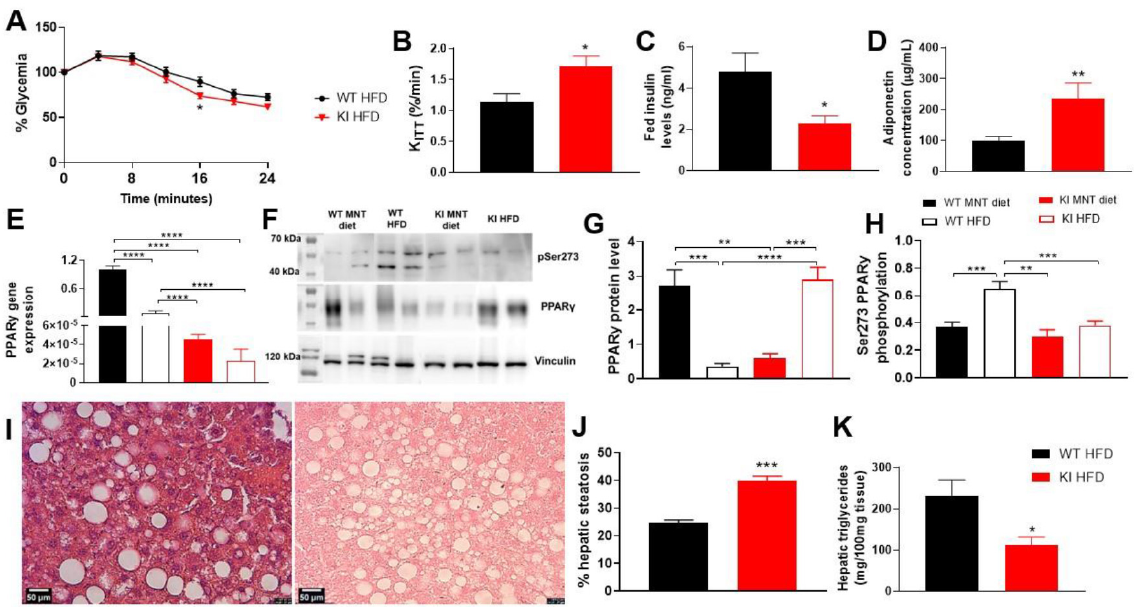
Figure 4. Characterization of KI S273A lineage after 18 weeks of high-fat diet (HFD). ( A ) Percentage of glycemia on insulin tolerance test (ITT) comparing WT and KI at the end of 18 weeks of HFD feeding. ( B ) Glucose disappearance rate (KITT) after ITT, ( C ) plasma insulin levels, and ( D ) plasma adiponectin concentration, comparing WT and KI PPAR γ S273A animals. ( E ) Relative normalized expression of PPAR γ in white adipose tissue (WAT) comparing WT (C57) and KI with MNT and HF diets (HFD). ( F ) Western blotting in eWAT for vinculin, PPAR γ , and S273 phosphorylated. Densitometry of bands to quantify ( G ) PPAR γ normalized to vinculin and ( H ) S273 phosphorylated, normalized to vinculin. ( I ) Representative liver histological images using hematoxylin-eosin stain of 5 µm paraffin slices, ( J ) quantification of hepatic steatosis using Weka segmentation on Fiji/ImageJ and ( K ) hepatic triglycerides. Data are represented as mean ± SEM. Statistical analysis was performed using non-parametric t -test to compare two groups and Dunnett’s T3 multiple comparison ANOVA test. * p < 0.05, ** p < 0.01, *** p < 0.001 and **** p < 0.0001. n ≥ 3 per group.